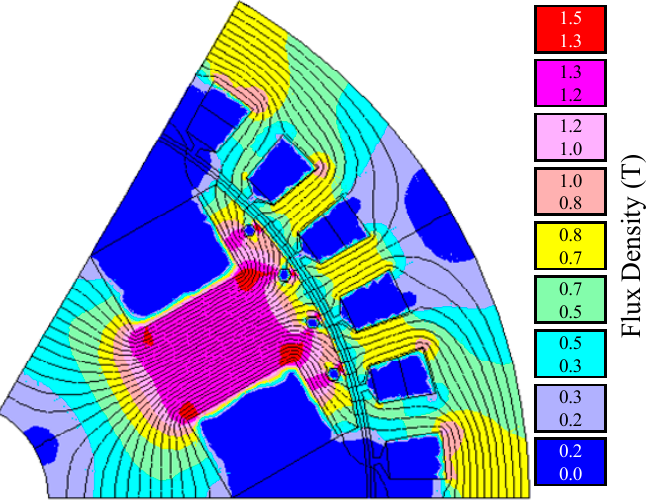
Figure 10. Finite-element solution of the magnetic field distribution and magnetic flux density under no-load operation.